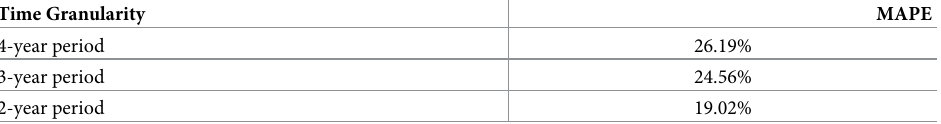
Table 5. Mean Absolute Percentage Error(MAPE) for different granularities of time.